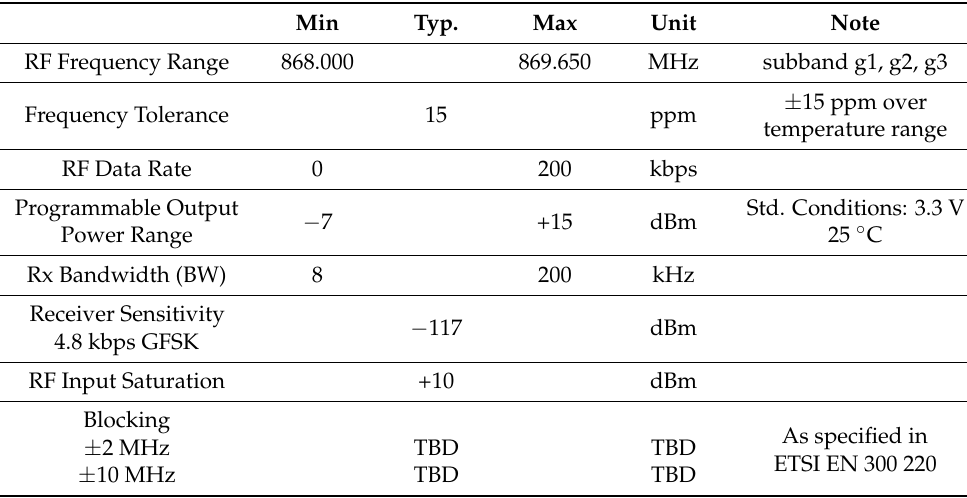
Table 2. EMB-WMB868 RF Characteristics (Vcc = 3.3 V 25 ◦ C) [29]. Min Typ. Max